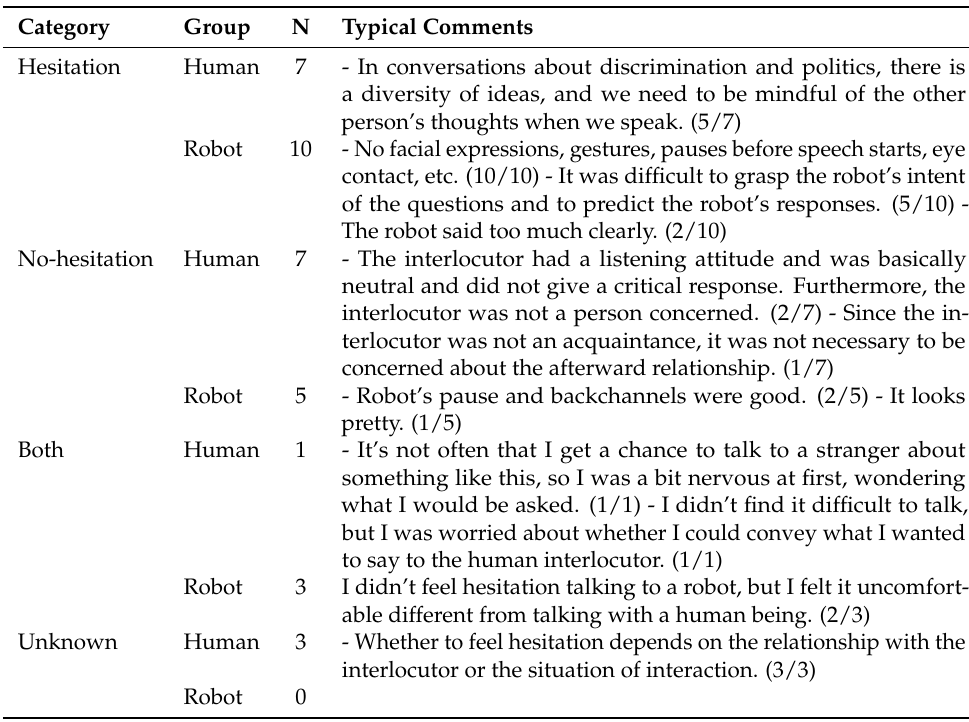
Figure 7. The number of characters of pre- and post-descriptions. Table 2. The results of categorizing participant’s description about their hesitation in the dialogue. Typical comments are our aggregation of the participants’